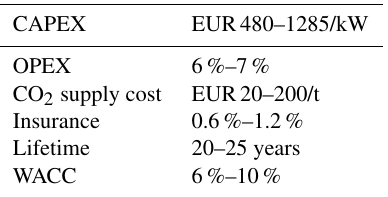
Table 4. Expected costs of a power-to-methanol plant by 2030 (ex- cluding input